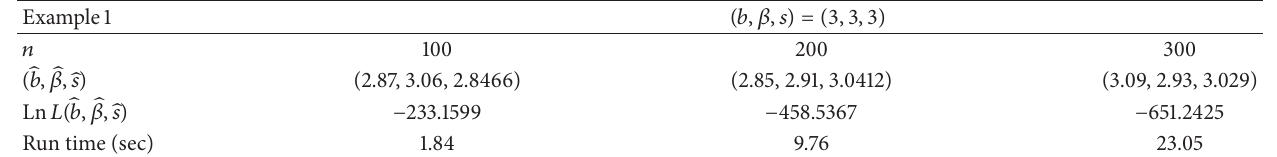
Table 2: Experimental result for